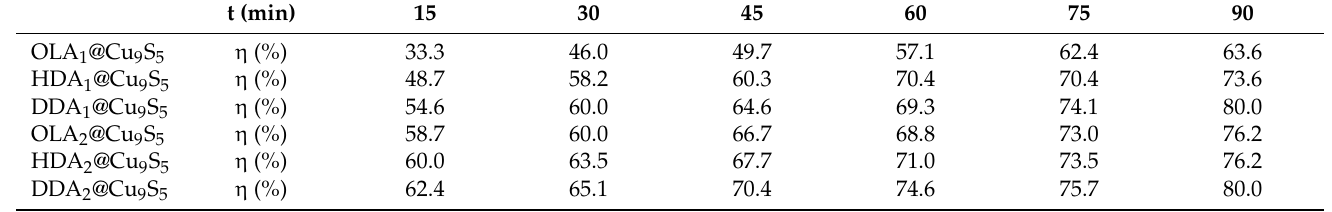
Figure 10. Degradation-efficiency curves of MB at different irradiation times using ( a ) complex 1 and ( b ) complex 2 at 190 °C.